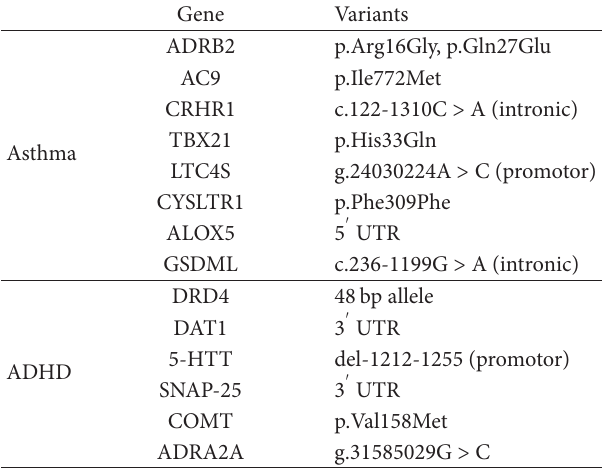
T 2: Identi�ed pharmacogenes in ADHD and asthma.